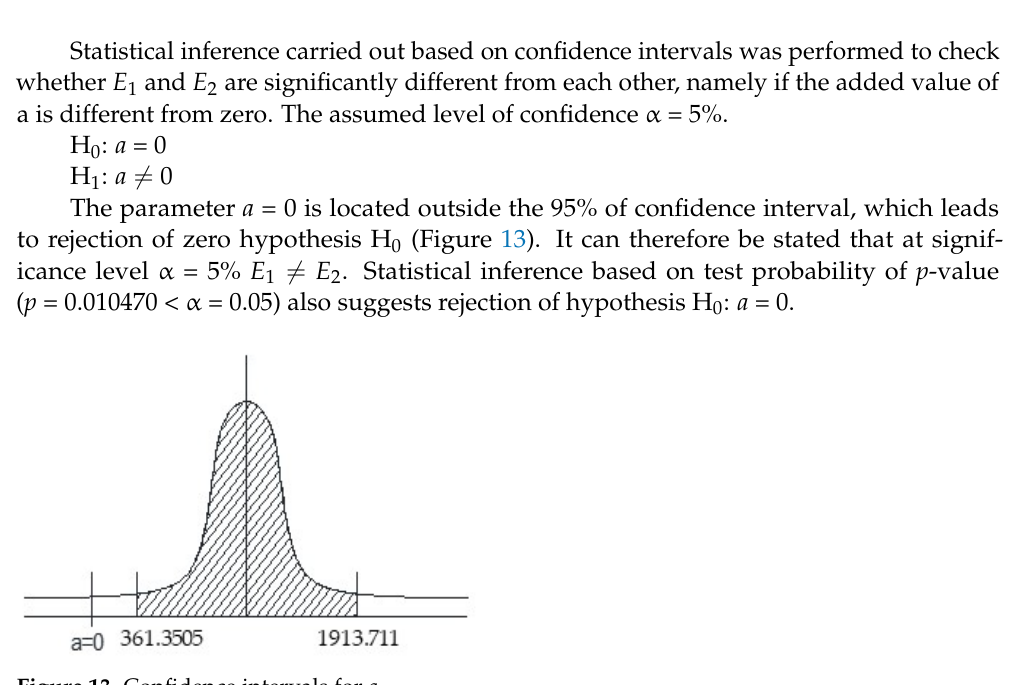
Figure 14. Matching of results of in-situ convergence measurements in Polkowice-Sieroszowice mine to convergence values obtained for effective parameters of pillars determined using statistical methods (elastic model). 0